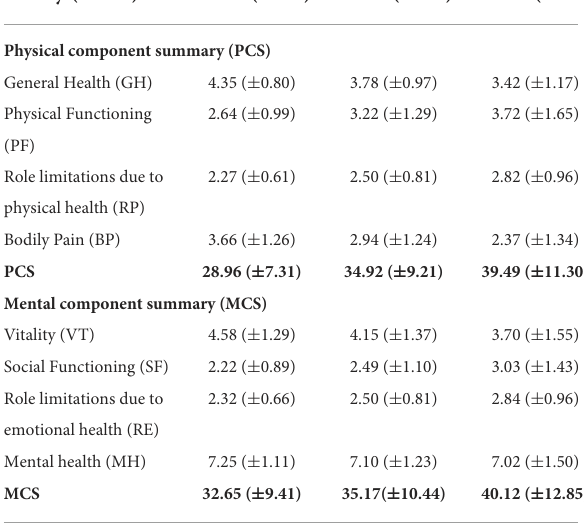
TABLE 2 The quality of life measured by the SF-12 (short form health survey).